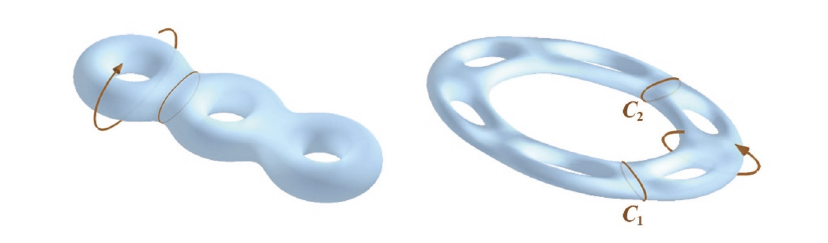
Figure 5 . Generators of the Torelli group I g . Left: Dehn twist along a separating curve. Right: the bounding pair